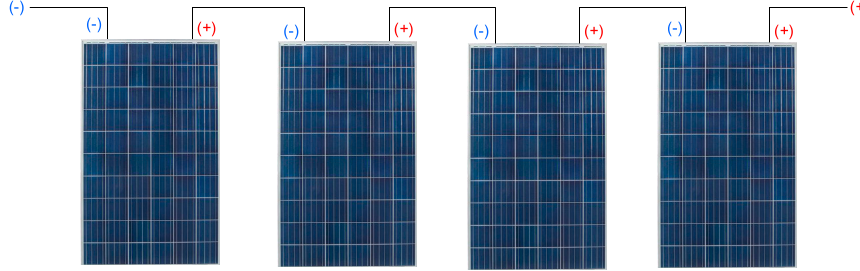
Figure 5. Series connection of photovoltaic panels.